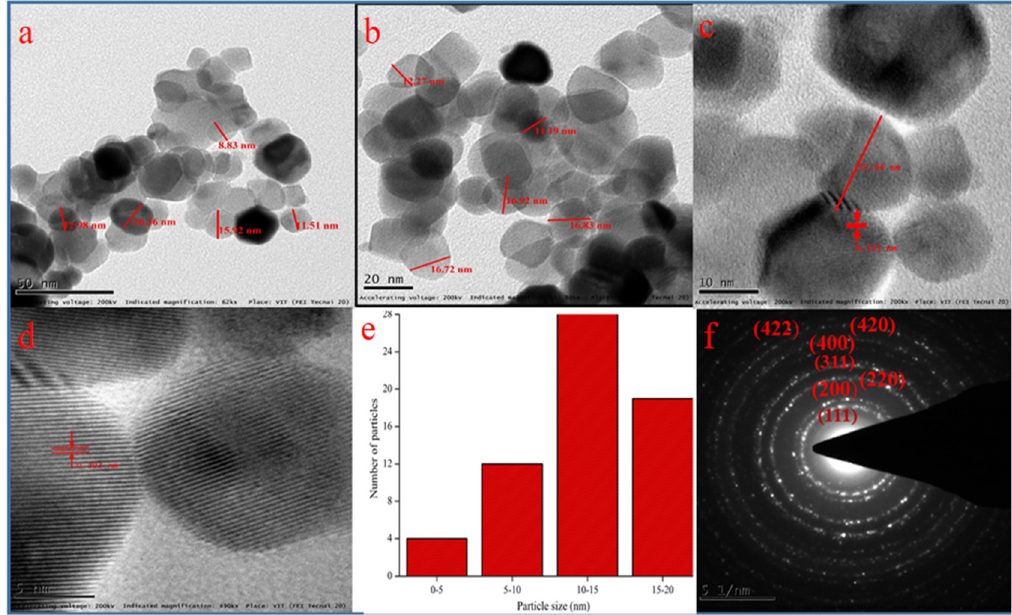
Figure 4. TEM images of CeO 2 NPs at di ff erent magnifications: ( a ) 50 nm, ( b ) 20 nm, ( c ) 10 nm, ( d ) 5 nm; ( e ) particle size histogram, ( f ) SAED pattern with hkl values.